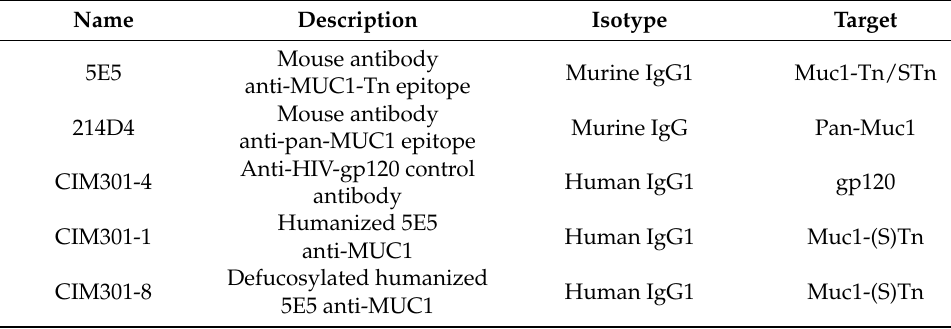
Table 1. Properties of anti-MUC1